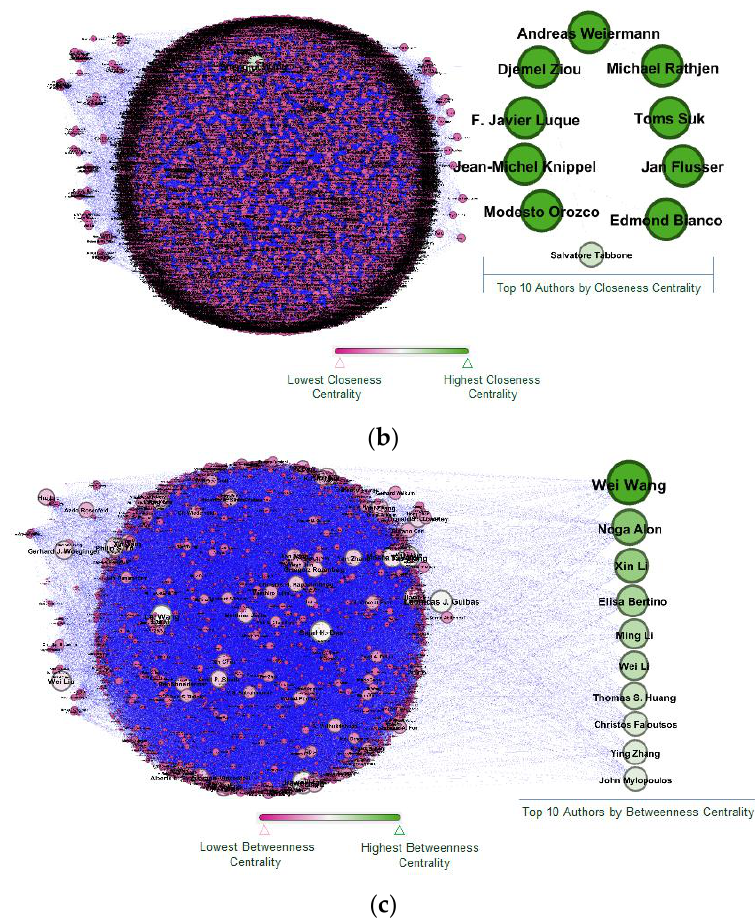
Figure A1. Part ( a ): Top 10 authors based on degree centrality, Part ( b ): Top 10 authors based on closeness centrality, Part ( c ): Top 10 authors based on betweenness centrality.